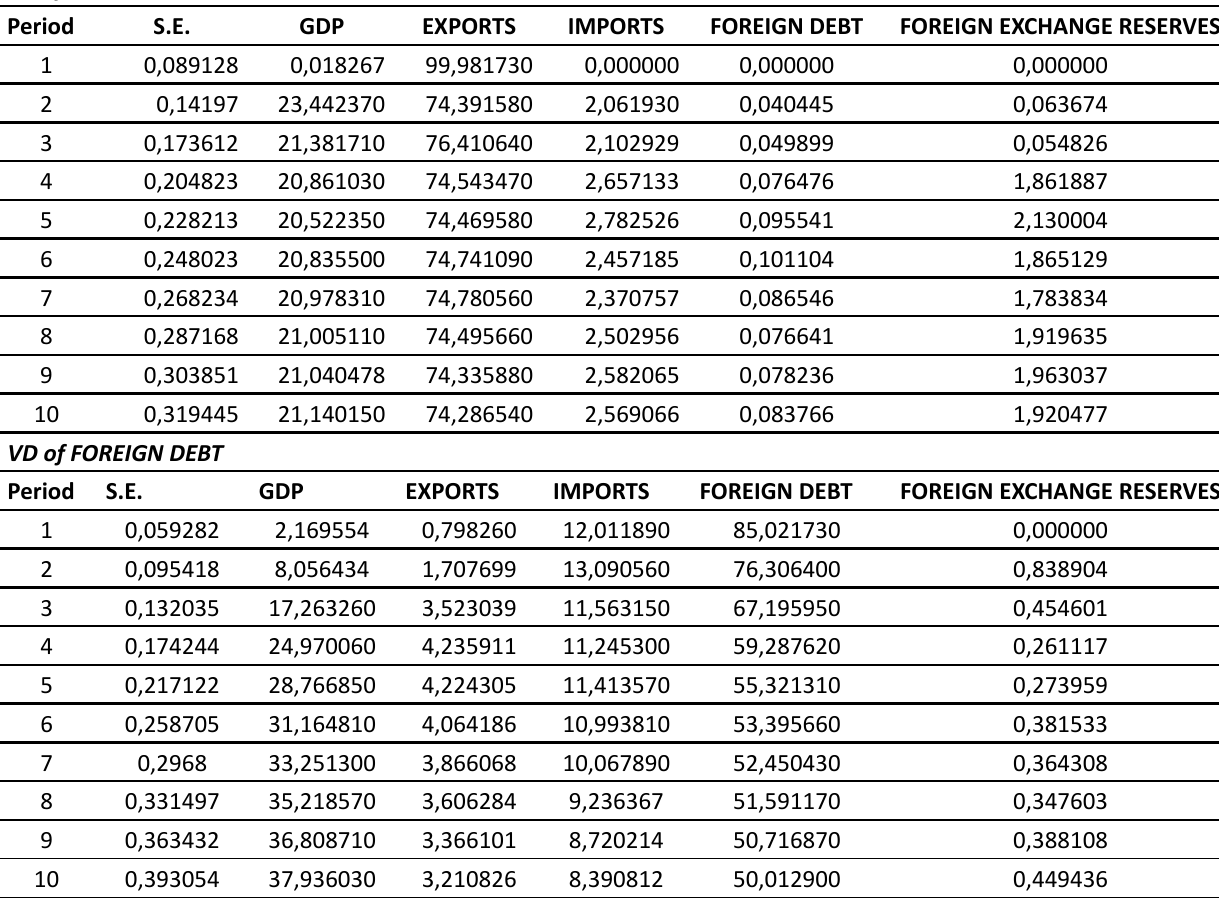
Table 7: VD Test of Exports and Foreign